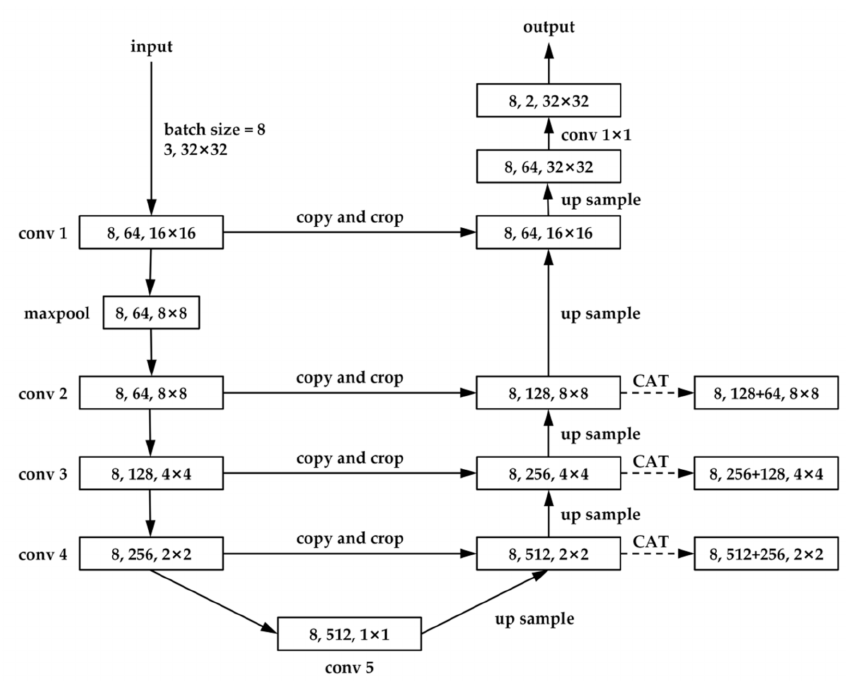
Figure 3. Network structure of Res-UNet. “conv” referring to the feature map. “CAT” is a method of concatenating feature maps with different numbers of channels.